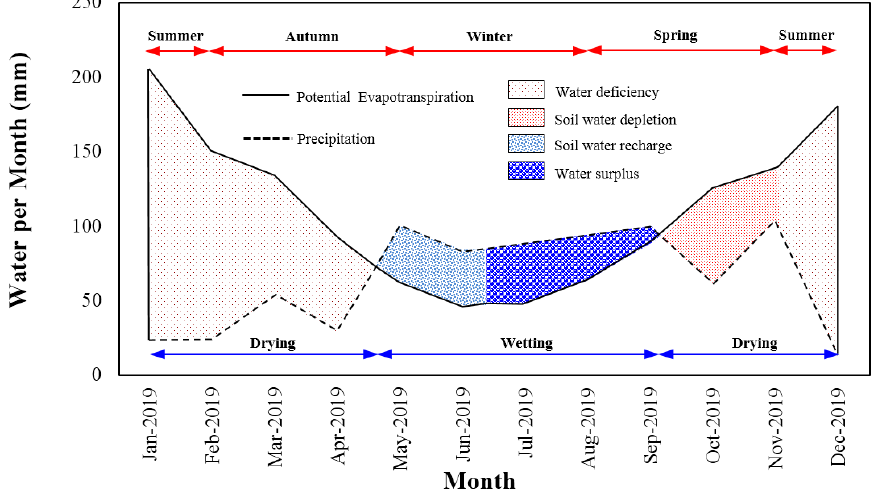
Figure 6. Soil moisture budget profile of the study site.